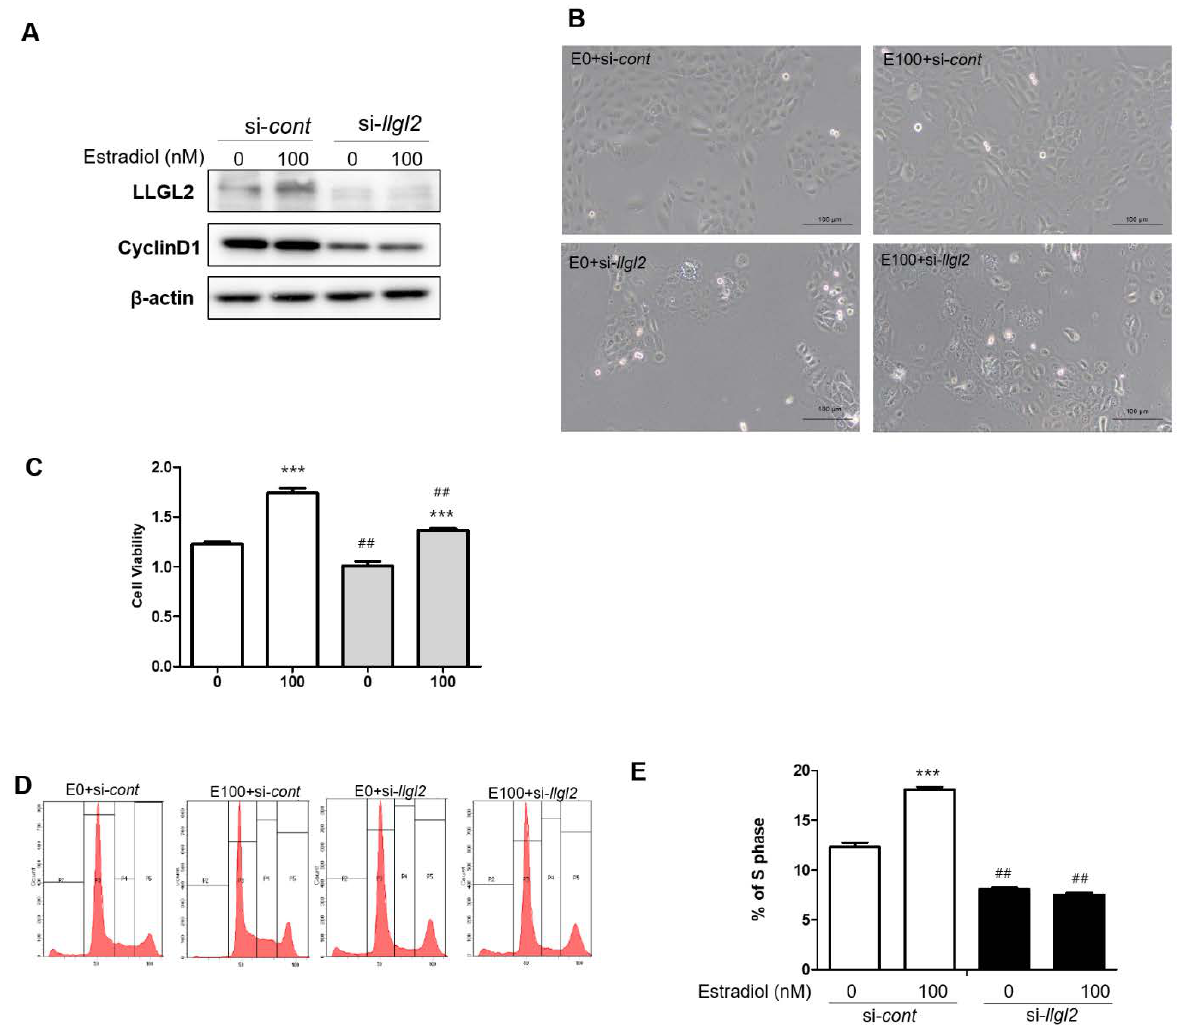
Figure 3. LLGL2 knockdown inhibits proliferation of E2-treated BPH-1 cells. BPH-1 cells were transiently transfected with a negative control siRNA ( si-cont ) or with LLGL2 siRNA ( si-llgl2 ) against LLGL2 for 48 h. After that, cells were treated with E2 (0 and 100 nM) for 24 h. ( A ) Western blot data showing LLGL2 and Cyclin D1 protein expression levels in E2-treated BPH-1 cells after LLGL2 knockdown. ( B ) Cell morphology and confluence images of BPH-1 cells under a phase- contrast microscope (magnification 100 × , scale bar = 100 µ m). ( C ) Cell proliferation capacity of LLGL2 knockdown in E2-treated BPH-1 cells by CCK assay. ( D ) Cell cycle of LLGL2 knockdown in E2-treated BPH-1 cells detected by a flow cytometer. ( E ) Graphical representation of S-phase in LLGL2 knockdown in E2-treated BPH-1 cells. Values are expressed as the means ± standard deviation; *** p < 0.001 versus E0 + si-cont group. ## p < 0.01 versus E100 + si-cont